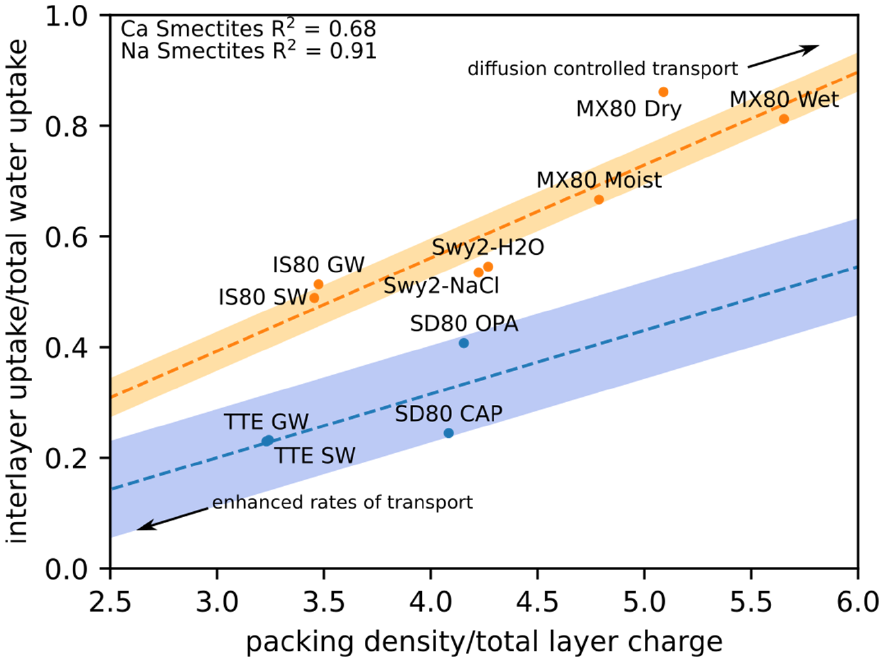
Figure 8. Plot showing the correlative relationships between the interlayer/total water uptake ratio versus the packing density/total layer charge ratios for Ca-(blue) and Na-(orange) bentonites (data source given in Table 3). The shaded areas correspond to the standard deviation of the data